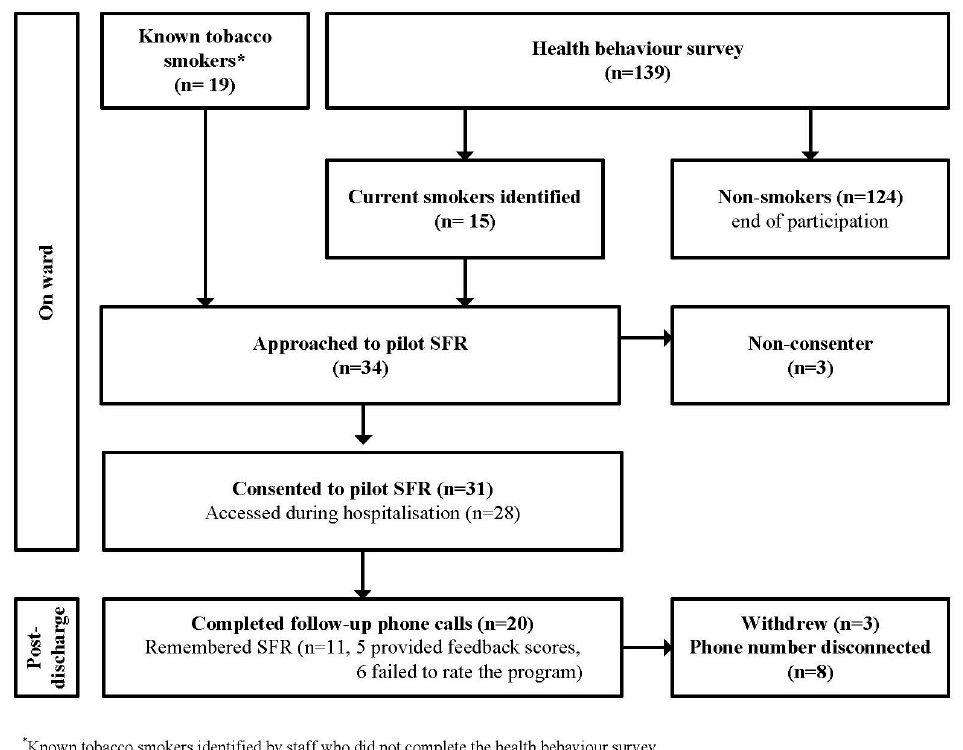
Figure 1. Participant recruitment flow for pilot trial of SFR.